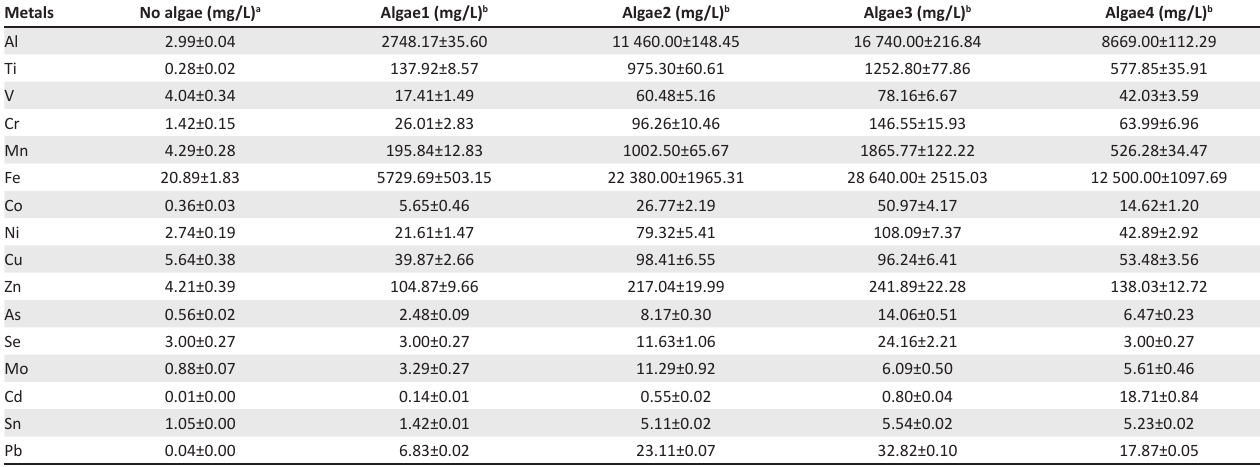
TABLE 3: The composition of metals in the pavement bricks and the presence of algae. Metals No algae (mg/L)